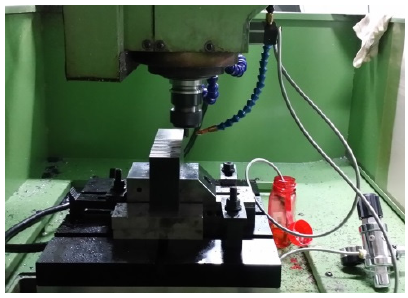
Figure 1. Experimental set ‐ up with a fixed position of the minimum quantity lubricant (MQL) nozzle.